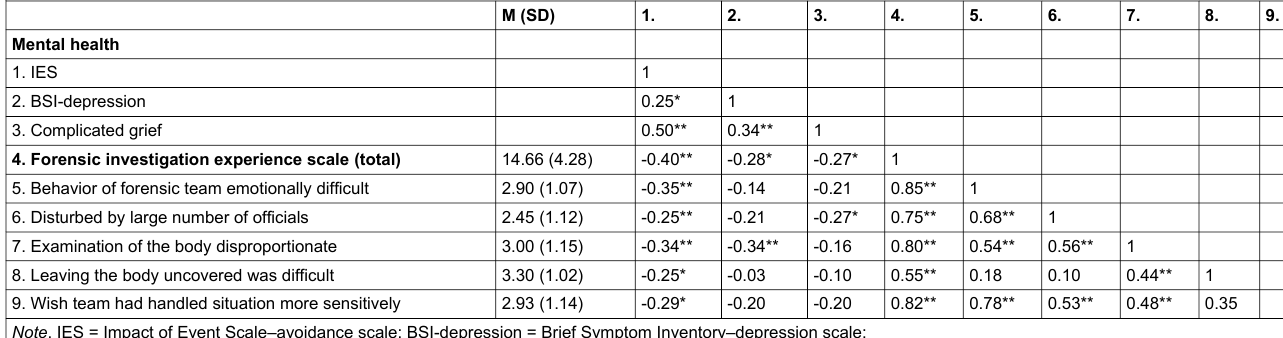
Table 3: Correlations of diagnosis of PTSD, CG, and depression with FIES scores (total and individual items).